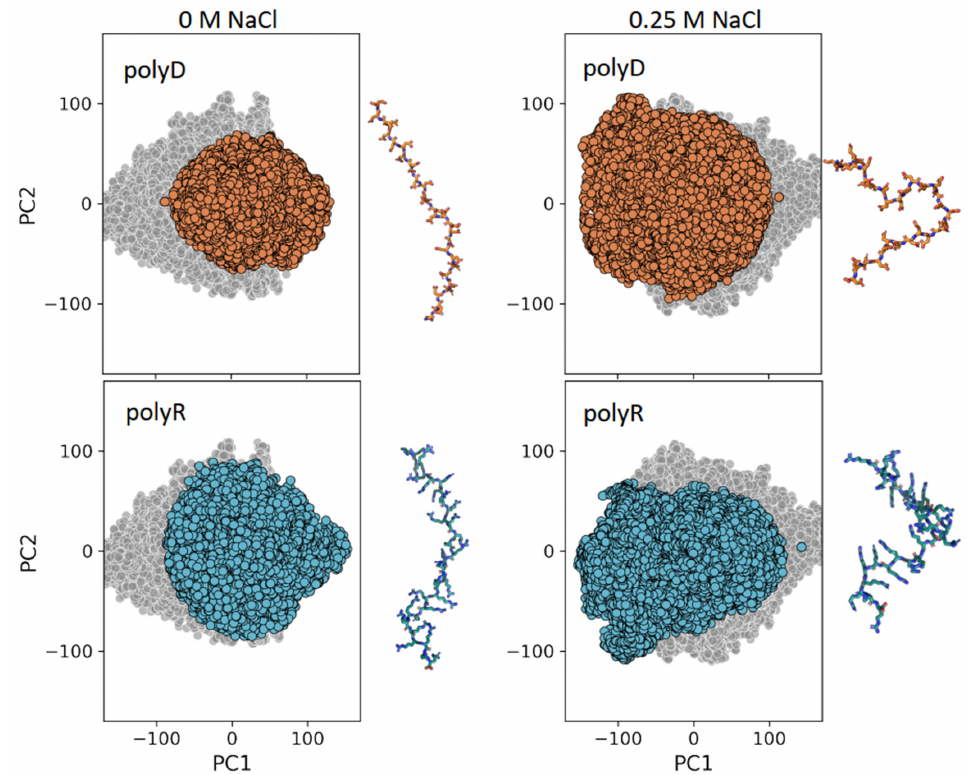
Figure 3. Conformational ensemble of charged homo-polypeptides. Projection of the first two principal components (PCs) from principal component analysis (PCA) of polyD (orange) and polyR (cyan) at NaCl concentrations of 0 M ( left ) and of 0.25 M ( right ). The projection for polyGS (gray) at the corresponding salt concentration is shown in the background of each panel for reference. Adjacent to each panel, a representative conformation is shown for each